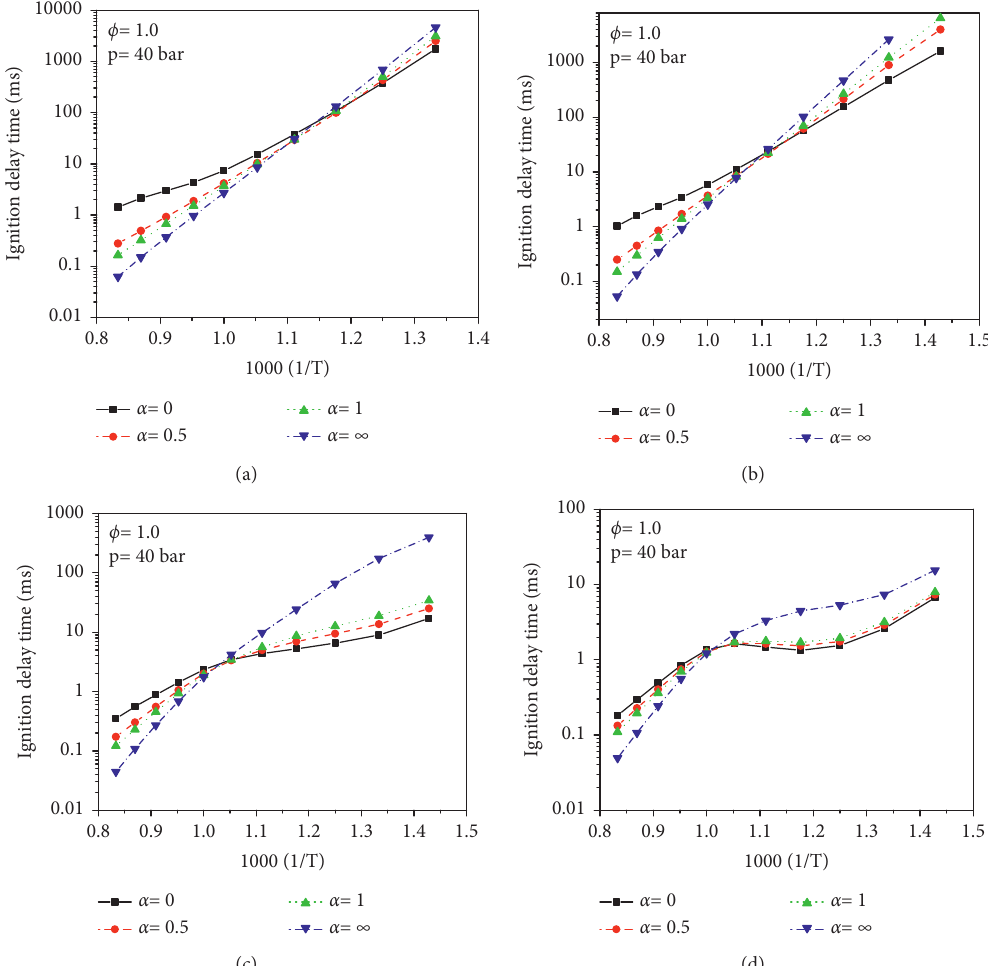
Figure 6: Ignition delay time of different α values for methane/H